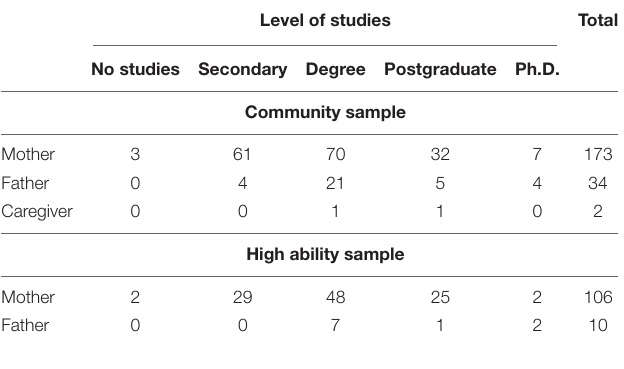
TABLE 1 | Educational level of parents and caregivers in the two samples. Level of studies Total No studies Secondary Degree Postgraduate Ph.D.